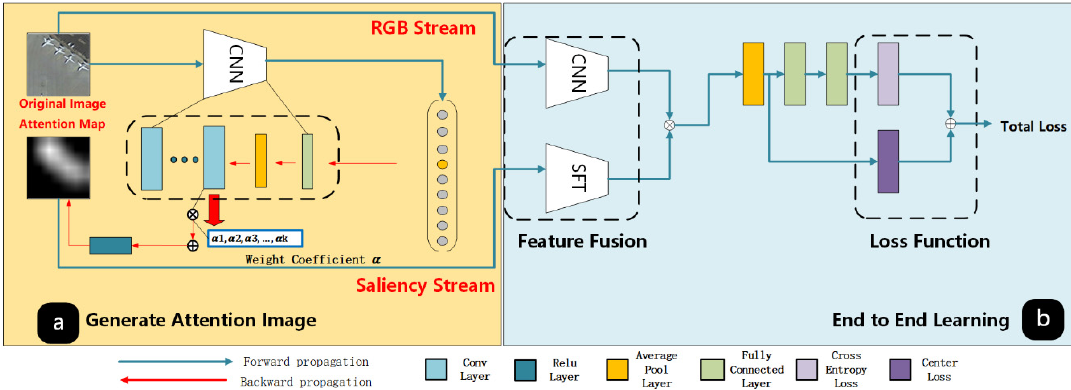
Figure 3. Overview of our framework, which is comprised of ( a ) convolutional neural networks (CNN) pretrained on ImageNet and fine-tuned on training dataset and Grad-CAM architecture to generate discriminative attention map, and ( b ) a two-stream architecture to fuse high-level features extracted from original image and attention maps and combine multiple loss functions. For simplicity, the different color block represents different network structure layers, respectively.